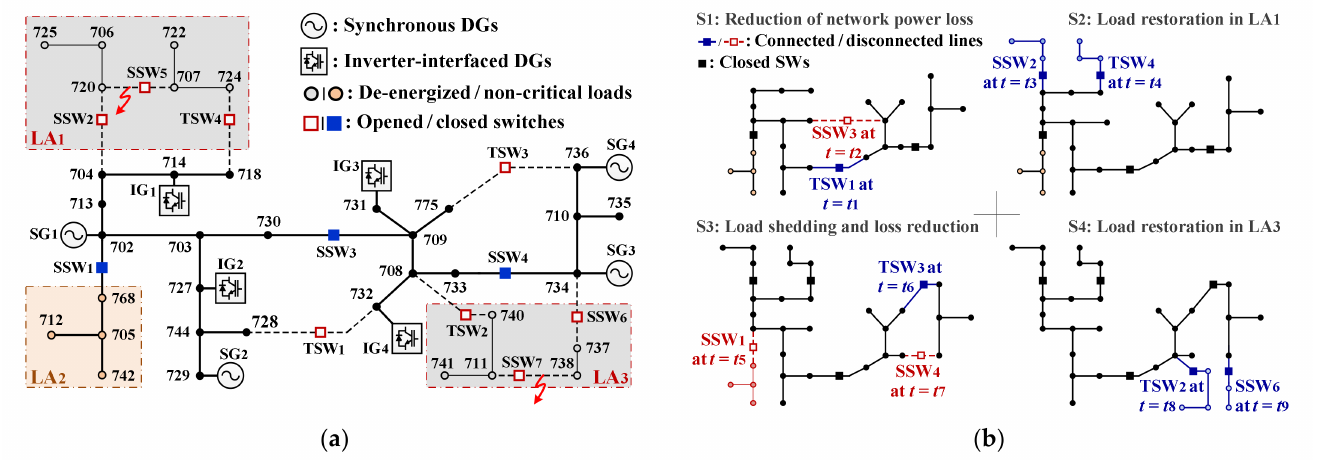
Figure 6. ( a ) A reconfigurable network with switches and synchronous machine-based and inverter- interfaced generators and ( b ) the variations in the topology that reduce power loss and restore and shed